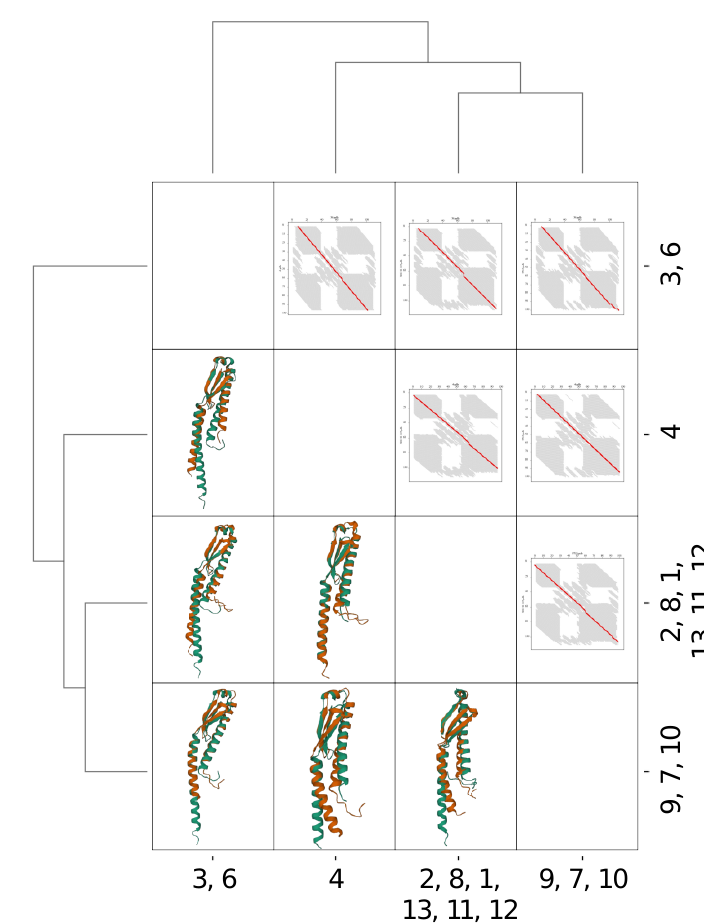
Figure 5. Pairwise alignment of monomeric structures of putative proteins belonging to the YbaB/EbfC family (IPR004401). Accession: Q3ANM6 (Group 3, 6), Q5L6F1 (Group 4), Q3KFA7 (Group 2, 8, 1, 13, 11, 12), and P75502 (Group 9, 7, 10). Structures were predicted using AlphaFold [50]; pairwise structural alignment was created using FATCAT [52]; and superimposed structures were visualised using Mol*Viewer [51]. The graph of the FATCAT chaining result is represented in the upper right corner, and the superimposed structures are shown in the lower left corner.